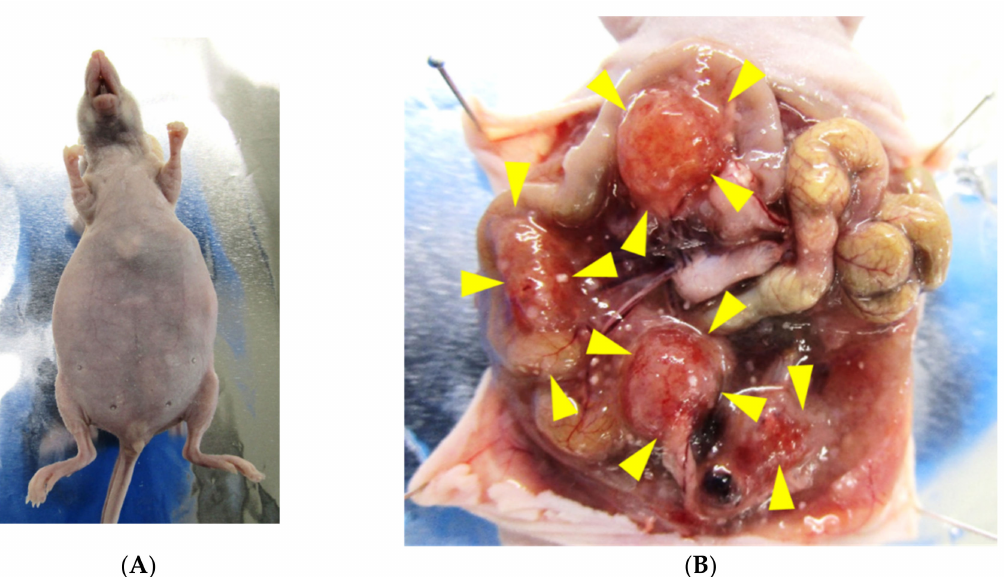
Figure 5. Tumorigenesis in nude mice. NCC-PMP1-C1 cells transplanted into BALB/c nude mice were capable of tumorigenesis. The mice typically presented abdominal distension ( A ) and a gelati- nous morphology with mucinous excrescence ( B ). Yellow arrowheads indicate the presence of tumor nodules on the serosal surface of visceral organs ( B